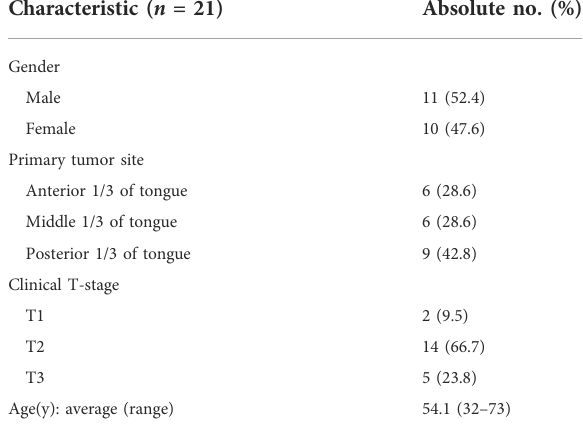
TABLE 1 Characteristics of patients who received peritumoral injection of ICG: HSA. Characteristic ( n =